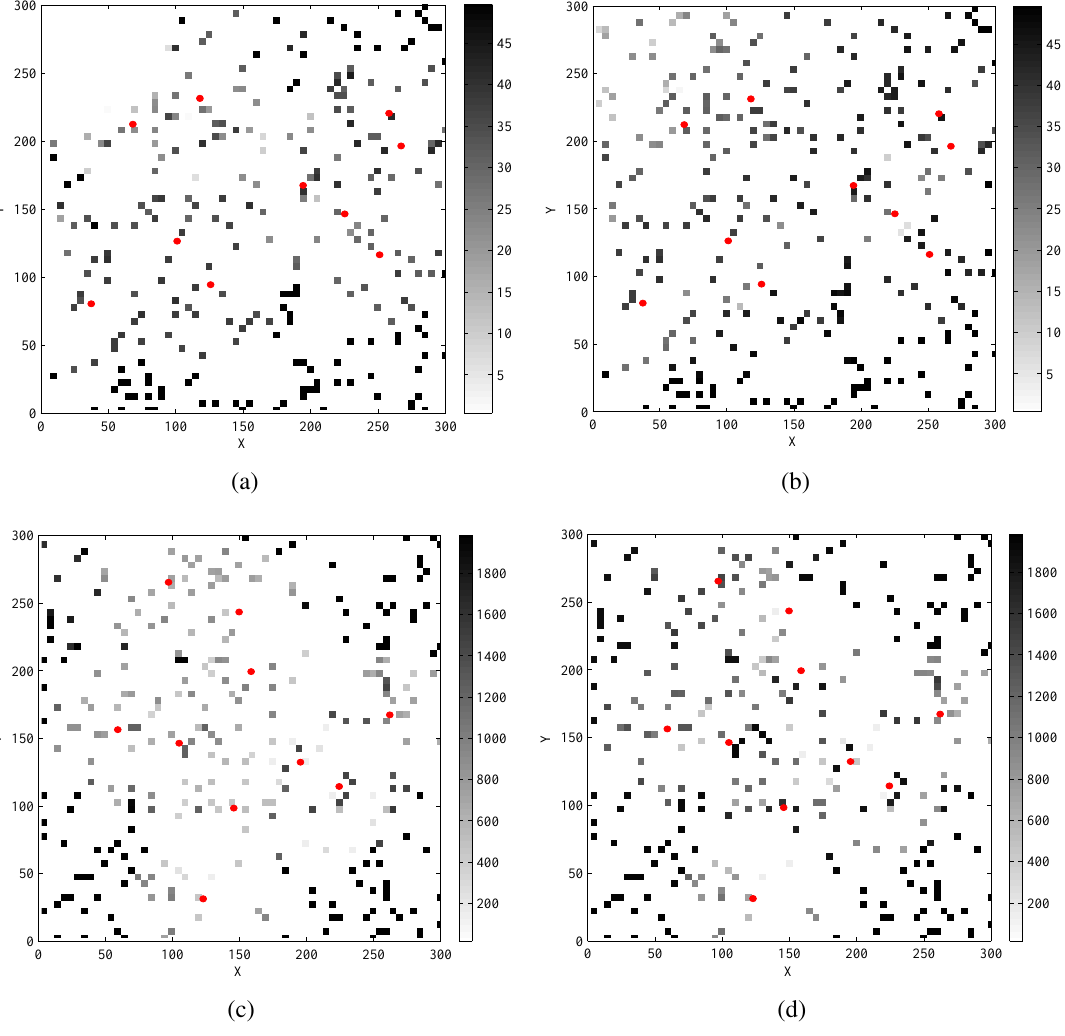
Figure 5. The snapshots of the remaining energy of sensors by (a) REFS and (b) EEFS in scenario 1 and (c) REFS and (d) EEFS in scenario 2, where the snapshots are taken from the end of the 27th round in scenario 1 and are taken from the 3800th minute in scenario